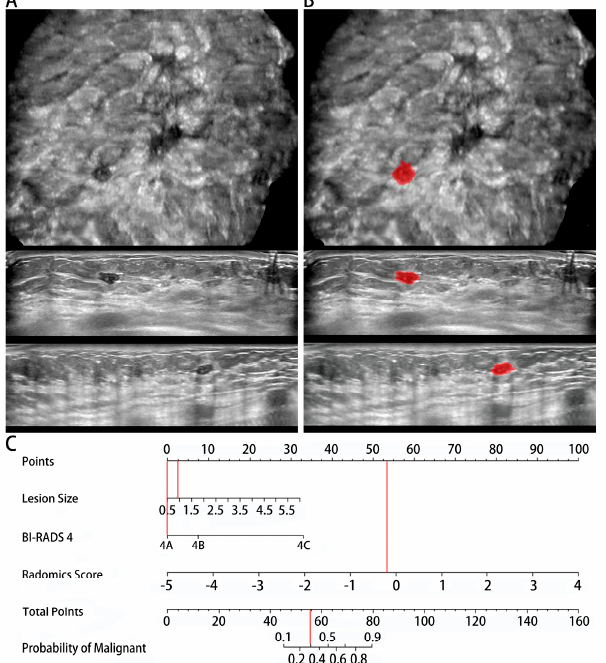
Figure 6. A false negative case of the radiomic nomogram. ( A ) Coronal, axial, and sagittal ABVS images showed a 0.9 cm BI-RADS 4A lesion, which was pathologically confirmed as invasive breast cancer. ( B ) Lesions were manually segmented on axial, sagittal and coronal ABVS images. ( C ) The probability of malignant calculated by the radiomic nomogram was less than 0.4, and the lesion will be missed diagnosis.